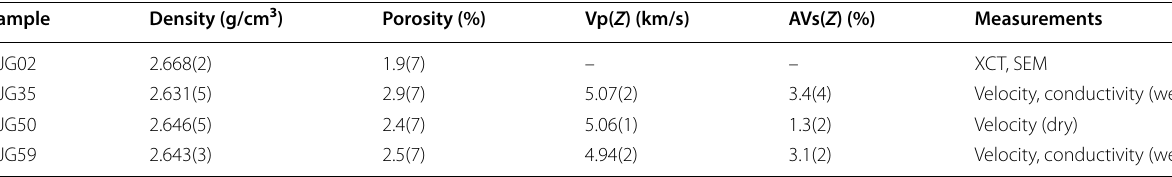
Table 1 List of samples